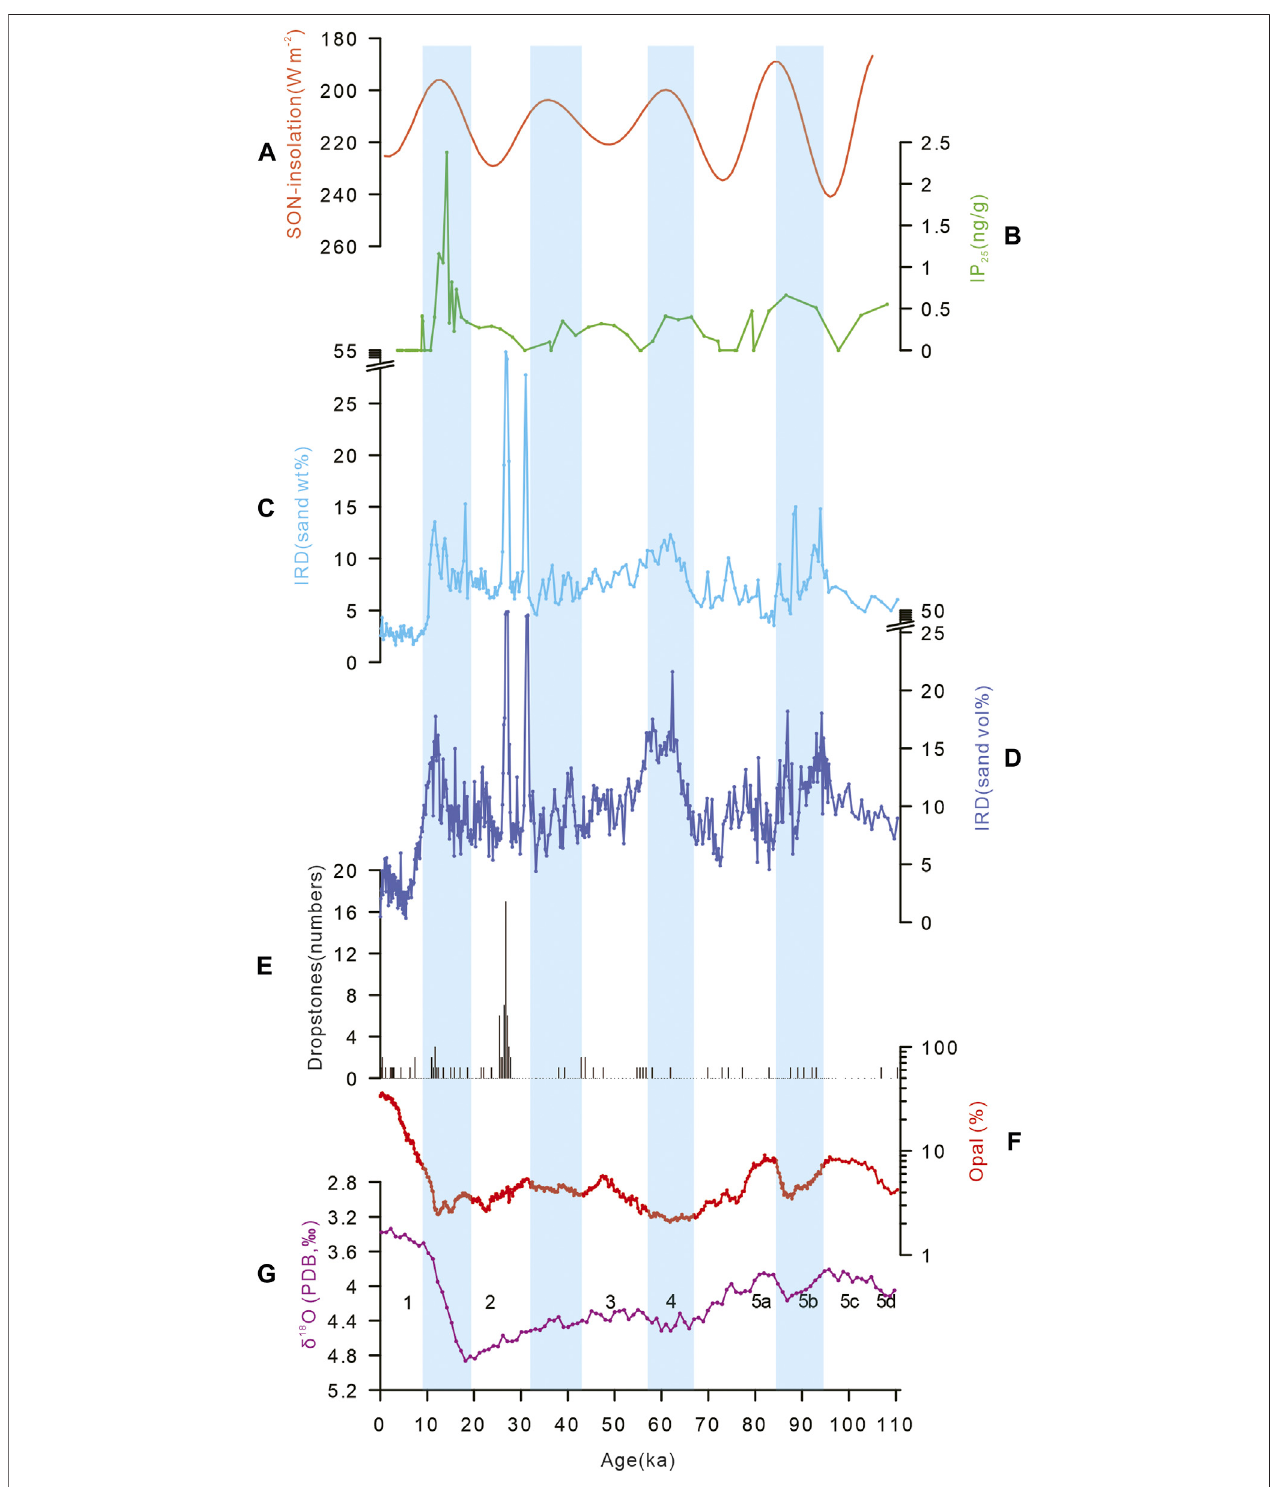
FIGURE 4 | Comparisons between variations in IRD proxies in core LV55-40-1 and other proxies. (A) SON-insolation (48 ° N; September, October, and November meaninsolation), (B) IP 25 contentincoreMD01-2414fromthecentralOkhotskSea,aproxyofseaice(Loetal.,2018), (C) IRD(wt%)incoreLV55-40-1, (D) IRD(vol%)in coreLV55-40-1, (E) NumberofdropstonesincoreLV55-40-1, (F) OpalcontentincoreLV55-40-1,and (G) LR04 δ 18 Ostack(LisieckiandRaymo,2005).Blueshadows represent intervals of sea ice expansion.